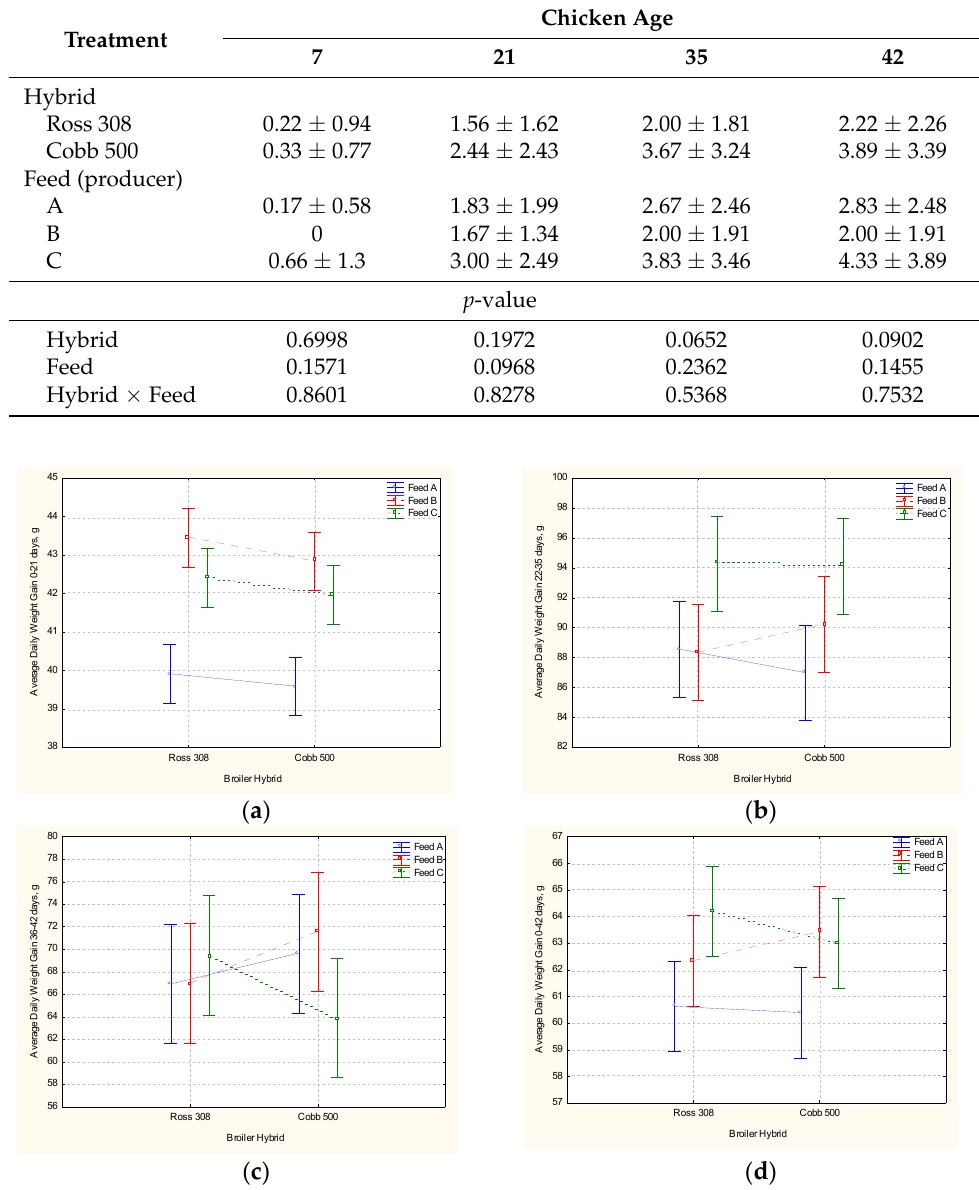
Figure 1. Average daily gain (g, means, vertical bars denote 0.95 confidence intervals) of different broiler hybrids fed different feed from the market (feed producer A; feed producer B; feed pro- ducer C) in different fattening periods: ( a ) Starter feed (from 0–21 days of age) of the producer A differ ( p < 0.0001), with no differences within hybrids ( p = 0.142) and without interaction of hy- brid × feed ( p = 0.924); ( b ) Grower feeds (from 22–35 days of age) of the producers A and C differ ( p < 0.001), without differences within hybrids ( p = 0.967) and interaction of hybrid and feed ( p = 0.545); ( c ) Finisher feeds (from 36–42 days of age) were no different within hybrids ( p = 0.783), feed ( p = 0.603), or hybrid × feed interaction ( p = 0.131); ( d ) The whole feeding program (from 0–42 days of age) of producer A differs significantly with feed B ( p = 0.020) and very significantly with feed C ( p = 0.002), without differences within hybrids ( p = 0.866) or hybrid × feed interaction ( p = 0.394). Similar to body weight, the graphs with the average values of the daily gain of the different broiler hybrids fed different market feeds even show a visually noticeable positive impact on the weight gain of the feeds used during the starter (feed B and feed C)